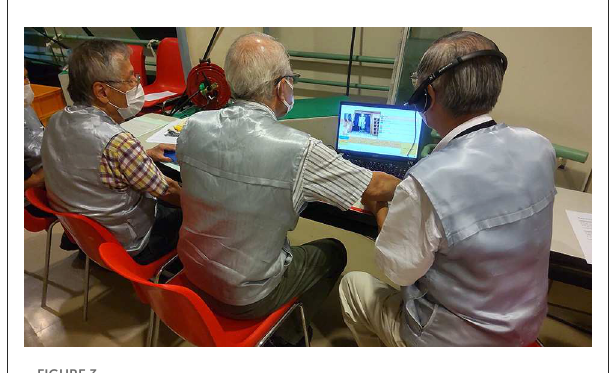
FIGURE3 The teleoperation setup in the children’s